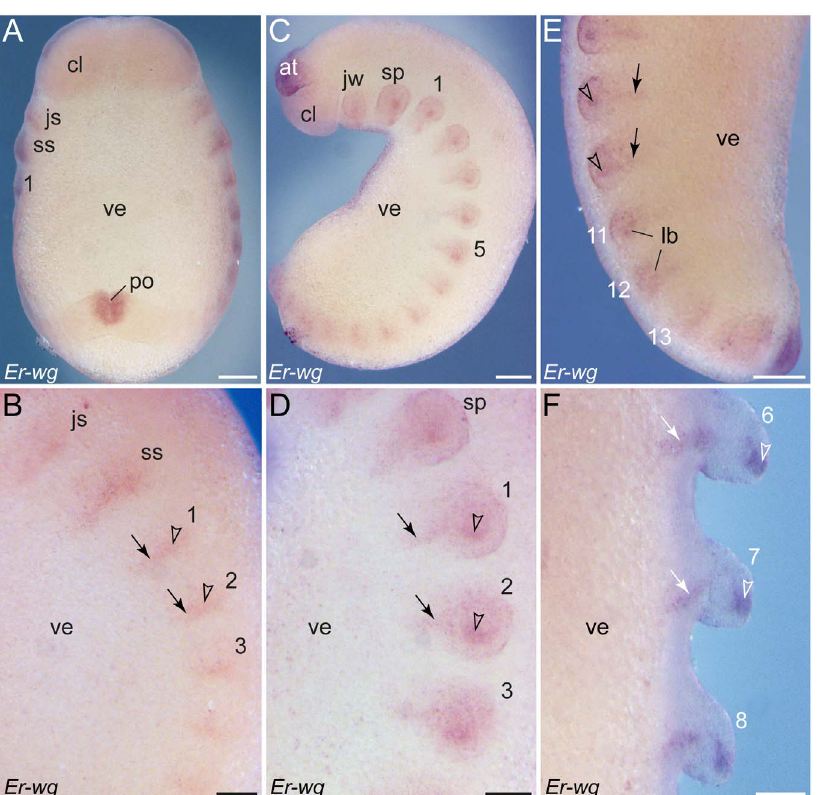
Figure 9. Expression of wingless in embryos of E. rowelli . Anterior is up in all images. Leg-bearing segments and corresponding limbs are numbered. (A) Stage II embryo in ventral view. Note that wingless is expressed in segmentally repeated stripes in the anlagen of limbs and in areas in which the limb buds arise. Note also wingless expression in the cephalic lobes and the proctodaeum. (B) Detail of wingless expression in the same embryo as in A in lateral view. Note that the expression first appears in the limb buds (arrowheads), followed by stripe-shaped domains in the ventral ectoderm (arrows). (C) Stage III embryo in lateral view. Note a weak and ubiquitous expression of wingless in the cephalic lobes and a strong expression in the anlagen of antennae. (D) Detail of wingless expression of the same embryo as in D in lateral view. Arrows point to appearing stripes along the ventral body surface, whereas arrowheads denote the spot-shaped domains in the distal portion of each developing limb. (E) Posterior end of a stage IV embryo in ventro-lateral view. As in the stage II and III embryos, the expression first appears in the limb buds (arrowheads), followed by stripe- shaped domains in the ventral ectoderm (arrows). (F) Detail of a stage IVembryo in ventral view. Note that the stripes in the ventral ectoderm are separated by non-expressing cells from the spot-shaped domains in the distal limb portions. Abbreviations: at , developing antenna; cl , cephalic lobe; js , jaw segment; jw , embryonic jaw; lb , limb buds; po , proctodaeum; sp , embryonic slime papilla; ss , slime papilla segment; ve , ventral extra- embryonic tissue. Scale bars: 250 m m (A, C), 125 m m (B, D), 200 m m (E), 100 m m